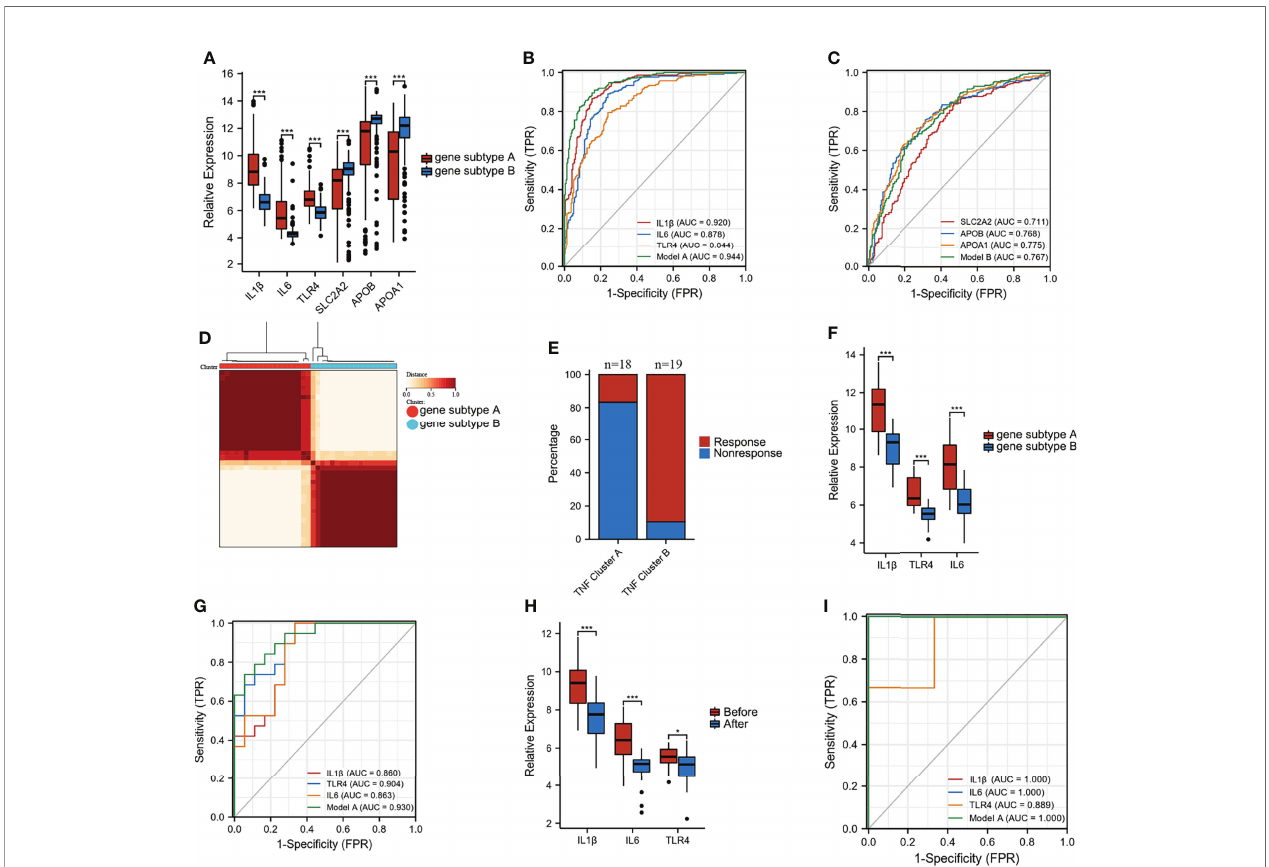
FIGURE 8 | Predictive and classify values of biomarkers. (A) The expression of six biomarkers in gene subtype A and B. (B, C) ROC curves to classify gene subtypes in merged dataset. (D) Consensus clustering matrices of top 100 nodes in GSE16879 (k = 2). (E) Stacked bar plot of percentage of response and non- response patients in two gene subtypes. (F) The expression of IL1 b , IL6, and TLR4 in two gene subtypes in GSE16879. (G) ROC curves to classify gene subtypes in GSE16879. (H) The expression of IL1 b , IL6, and TLR4 in response group before and after treatment. (I) ROC curves to classify gene subtypes in validation dataset GSE111761 (*p < 0.05 and ***p <